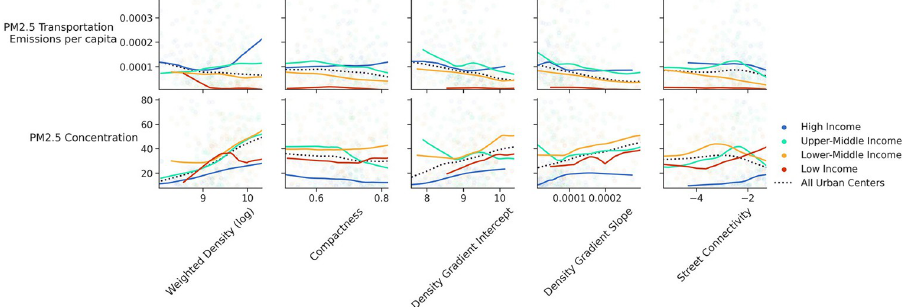
Fig 10. Correlation of urban form metrics with PM 2.5 measures across income